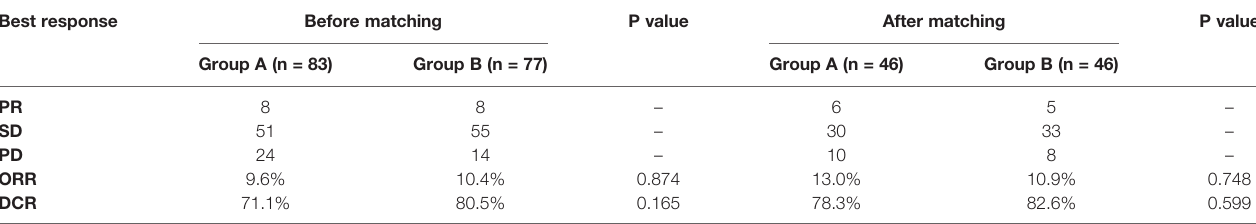
TABLE 3 | Comparison of the best response between the two Groups. Best